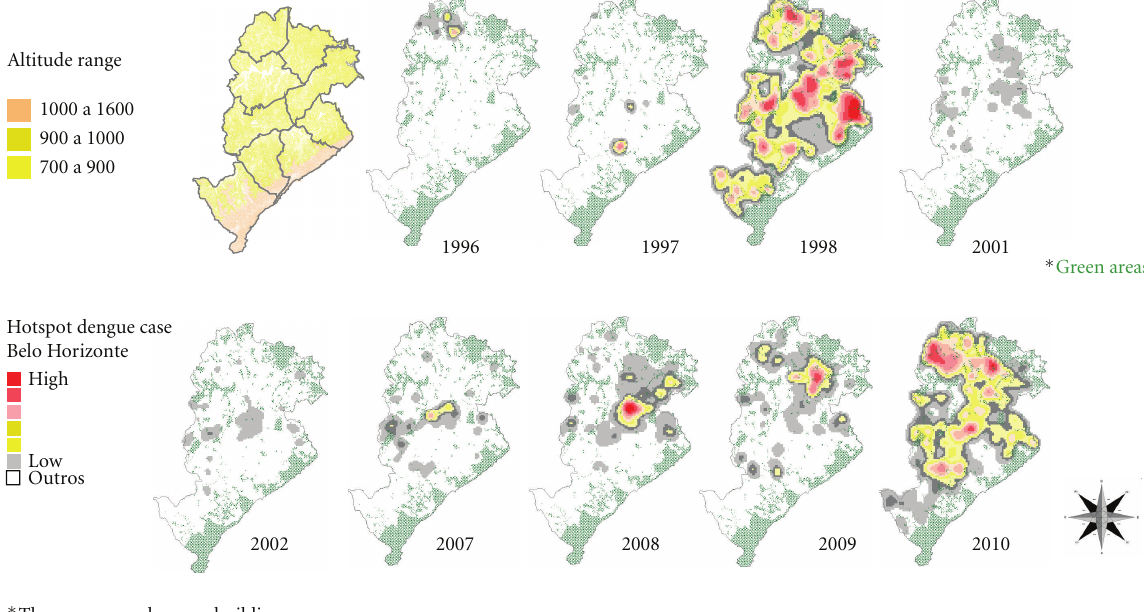
Figure 8: Dengue outbreaks, temporal dynamics in space, 1996–2011, and altitude range, Belo Horizonte/MG,